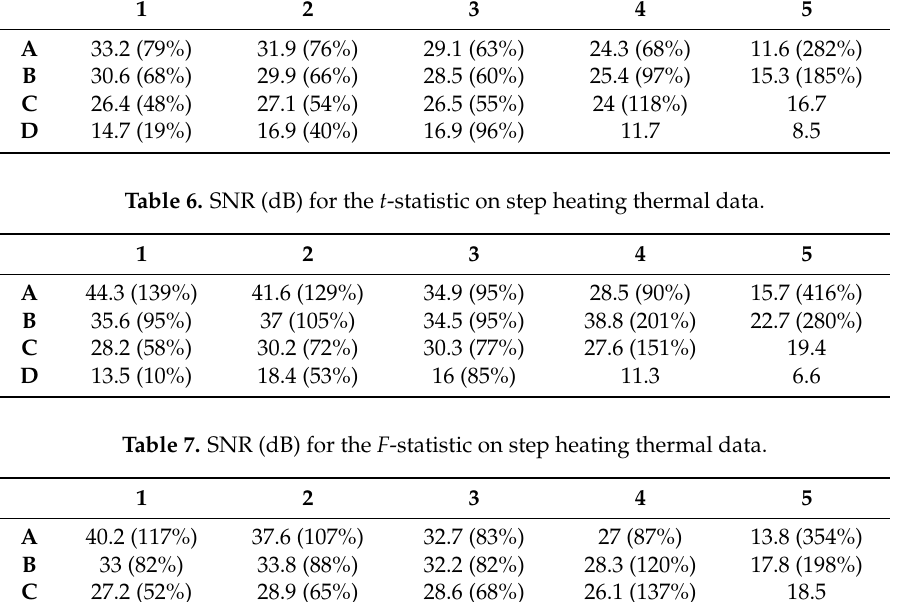
Table 5. SNR (dB) for ACE on step heating thermal data.